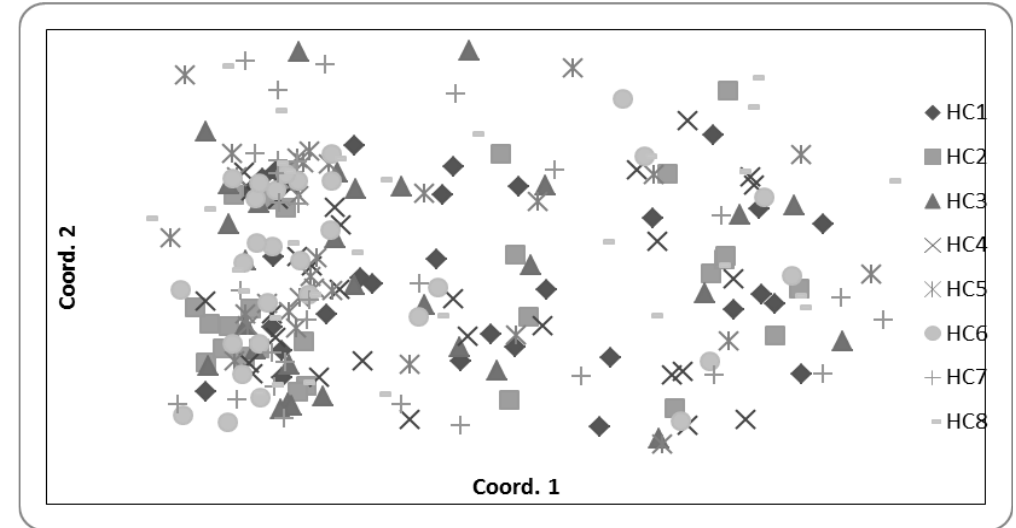
Figure 5. Plot of the Principle Coordinates analysis output showing the genetic relationship as measured at 10 microsatellite loci between all 237 individuals sampled across all populations, where symbols (see legend) indicate the population of each